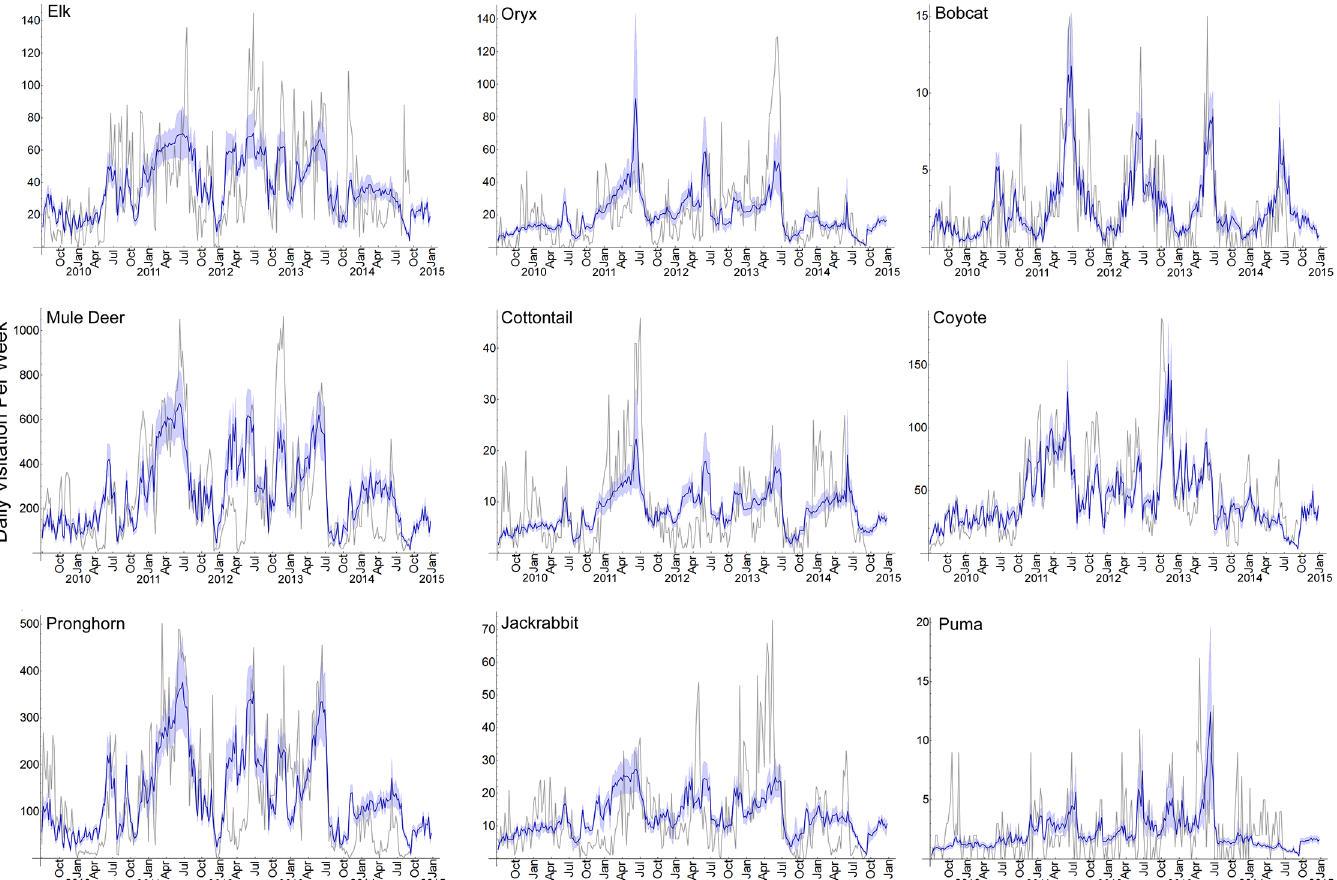
Fig 2. Model Fit. Visualization of the best model fit predicting the total visitation to water per week (blue line, with 95% confidence intervals as light blue coloring) for 9 mammals inhabiting Sevilleta National Wildlife Refuge, New Mexico, USA. Model predictions span June 29, 2009 through December 31, 2013, with data from 2009 – 2013 used to fit the model. Model projections occur from January 1, 2014 – December 31, 2014. Gray line indicates the actual number of visits observed each week.